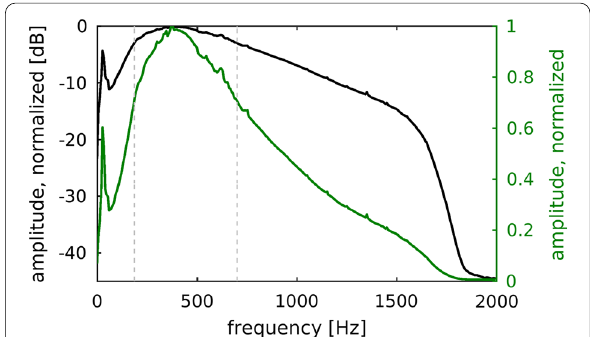
Fig. 2 Average amplitude spectrum of the unfiltered data using linear (green line) and dB scale (black line). The dominant frequency range (185–700 Hz) is indicated by the gray dashed lines. The peak in lower frequencies occurs at 50 Hz were picked manually for both P- and S-waves. We picked over all three components to ensure to get the right first arrival especially for the S-wave. Fig. 3 shows a receiver gather for receiver 9 in the TT niche. The first arrival of the P-wave (Fig. 3, red dot) is identical on all